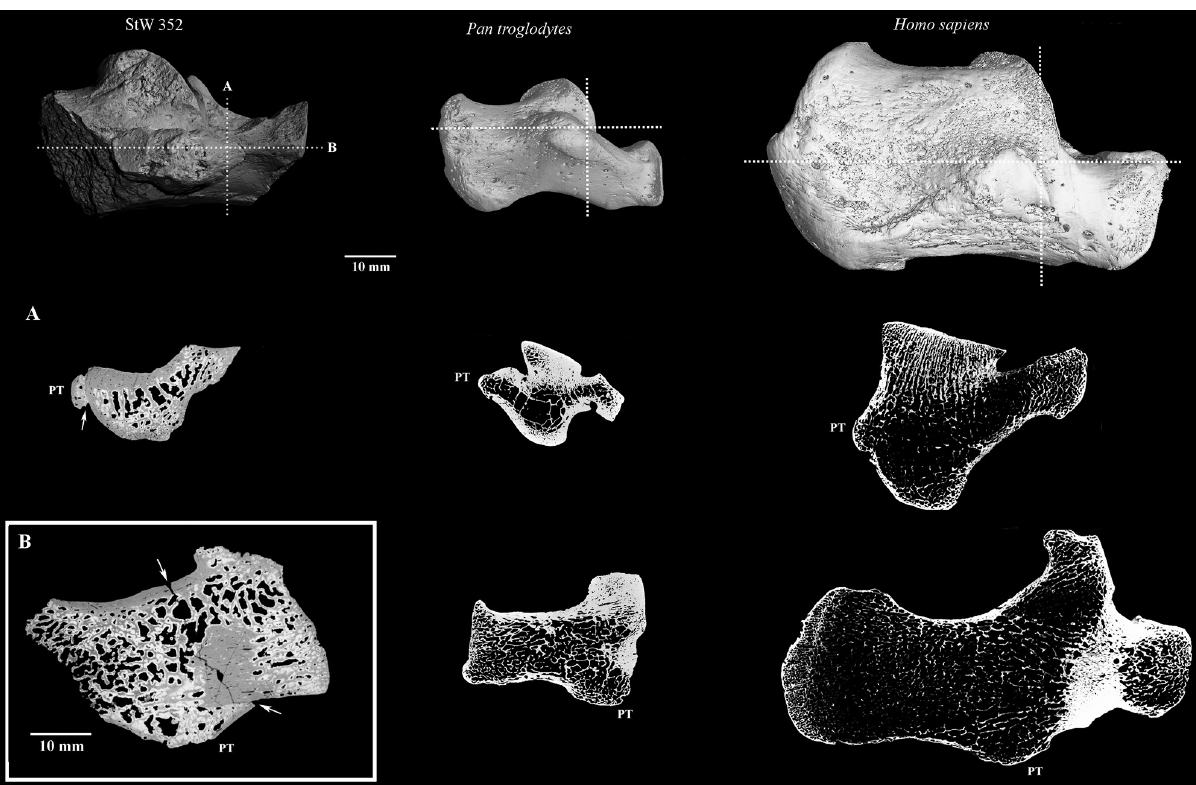
Figure 3: [From left to right] Top row: Lateral views of calcanei renderings from StW 352, Pan troglodytes and Homo sapiens showing the microCT sectional planes. Middle row: (A) Coronal section through the distal end of the peroneal trochlea (PT). Note the arrow indicating the presence of cortical bone under the PT of StW 352, but not in analogous locations in the comparative specimens. Bottom row: (B) Transverse section through the dorsal surface of the PT. Arrows indicate the location of both breaks through the body of StW 352 and the lack of similar cortical bone overlap in the comparative specimens.